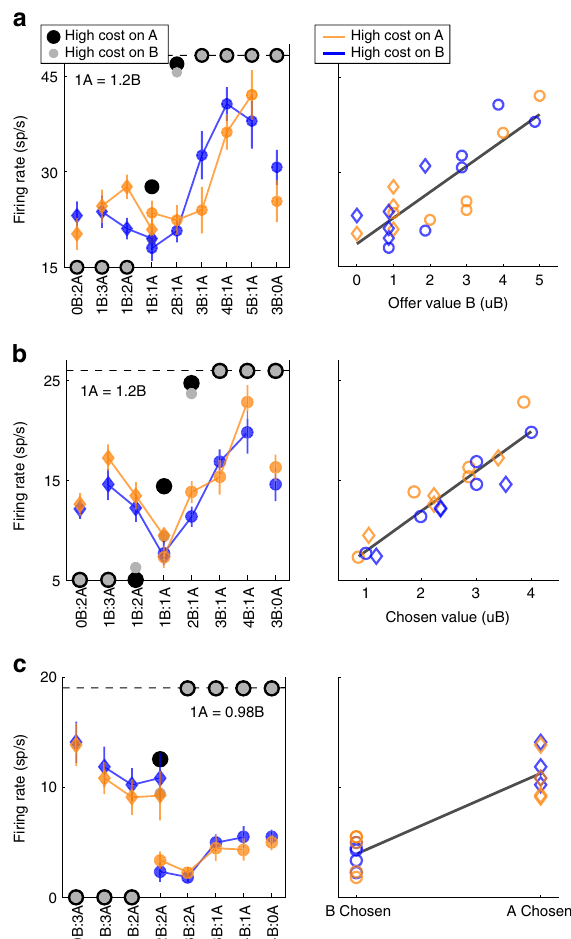
Fig. 2 Encoding of decision variables in juice-based reference frame.